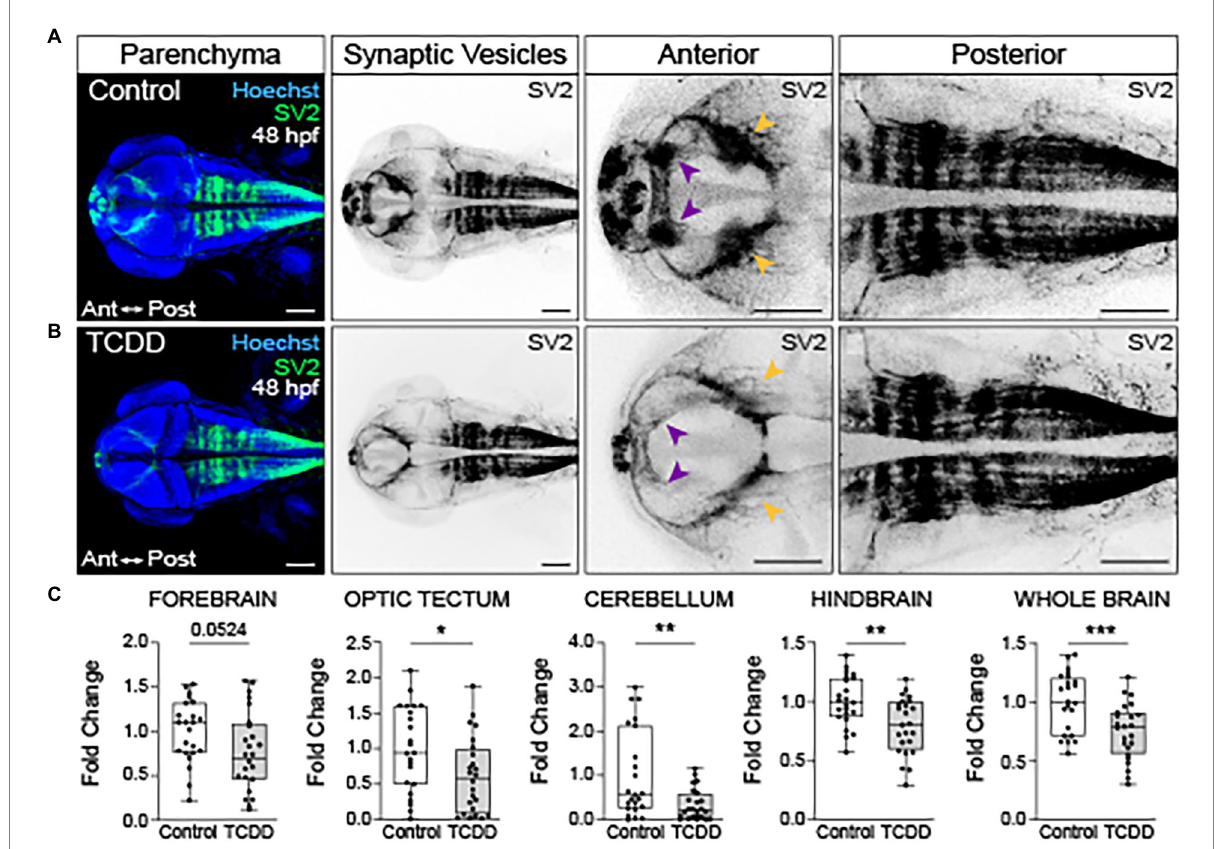
FIGURE 5 Embryonic TCDD exposure reduces synaptic vesicle 2 immunoreactivity. Dorsal confocal images of control (A) and TCDD-exposed (B) zebrafish at 48 hpf. The brain parenchyma was stained with Hoechst (DNA, blue) and immunolabeled with an antibody marking synaptic vesicle glycoprotein 2 (SV2) (green and inverted black). Forebrain vesicle production was decreased following TCDD exposure with notable reductions in the habenula (purple arrowheads). SV2 immunoreactivity was significantly reduced in the optic tectum (yellow arrowheads), cerebellum and hindbrain, and whole brain following TCDD exposure. (C) Fold change of SV2 immunolabeling in the forebrain, optic tectum, cerebellum, hindbrain, and whole brain was calculated relative to mean SV2 area coverage of controls. Statistical significance was determined by Welch’s t - test, * p < 0.05, ** p < 0.01, *** p < 0.001. n = 23–24 fish/group across 3 replicates. Scale bar = 100 μ m. Anterior (Ant) is left in all confocal